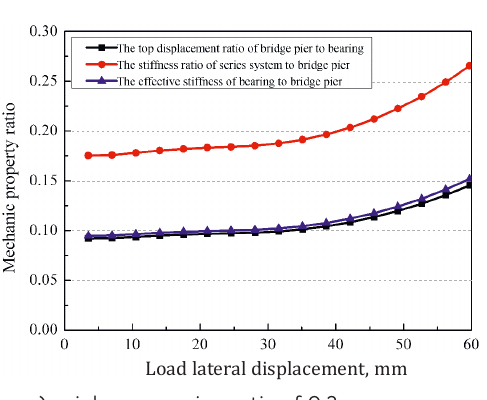
a) axial compression ratio of 0.1 b) axial compression ratio of